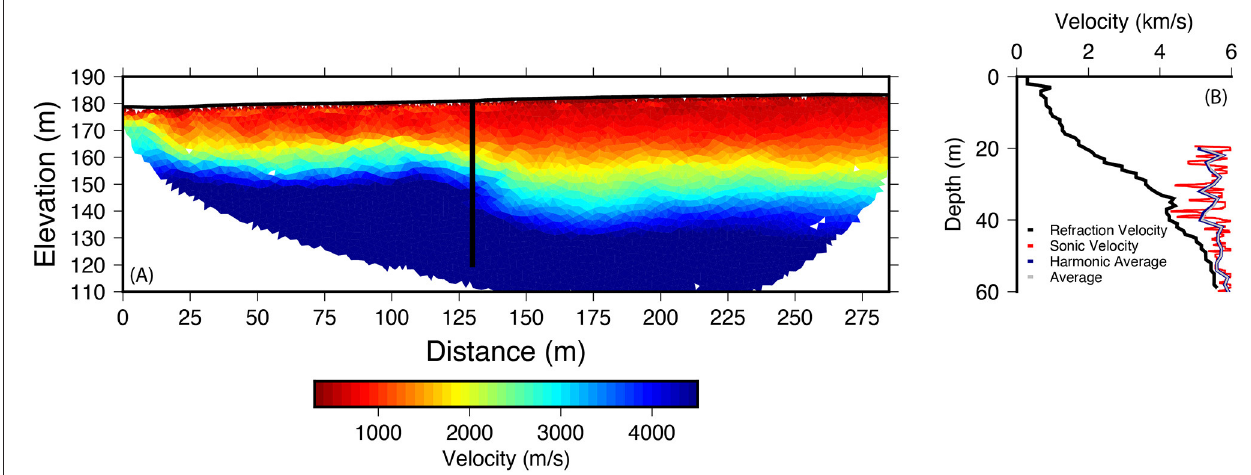
FIGURE 2 | P-wave and sonic velocity results presented by Holbrook et al. (2019). (A) P-wave velocity profile. (B) Comparison of sonic velocity (red) vs. extracted 1D velocity profile from (A) . The blue line is the harmonic average ( n